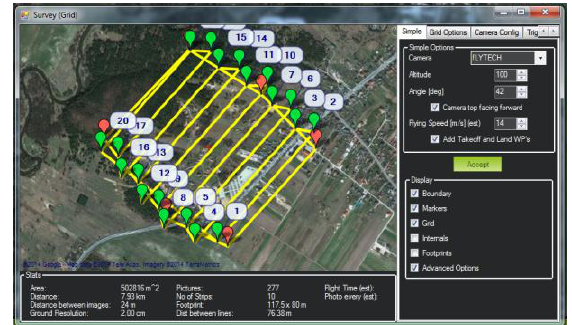
Figure 3. Flight plan made in software "Mission Planner" prepared for UAV.